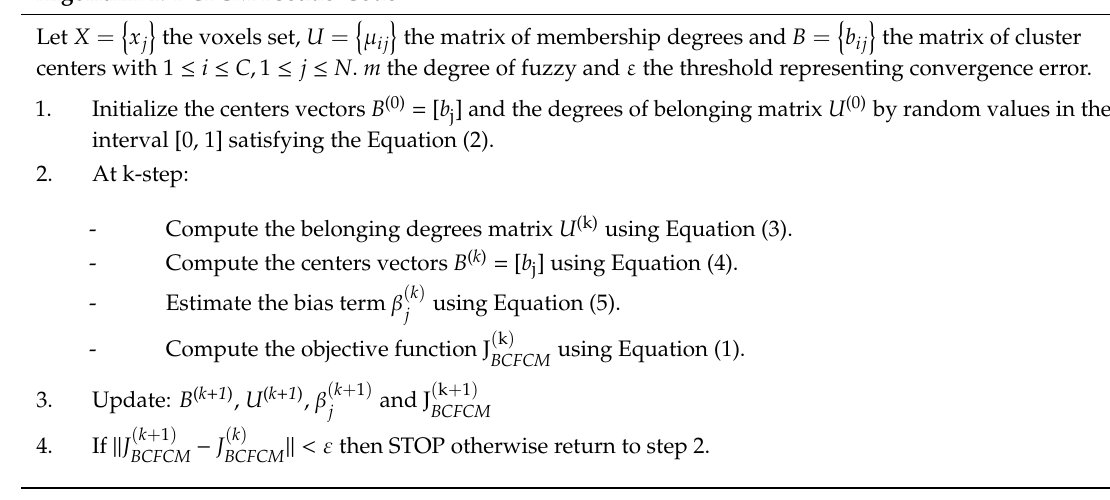
Algorithm 1: BCFCM